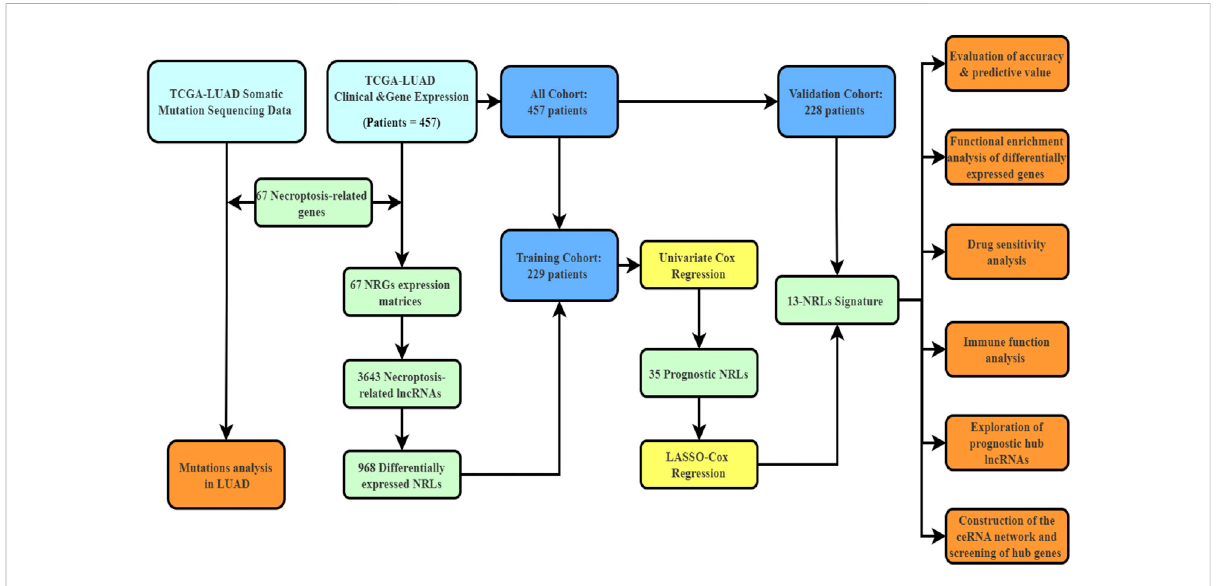
FIGURE 1 The work fl ow diagram of this